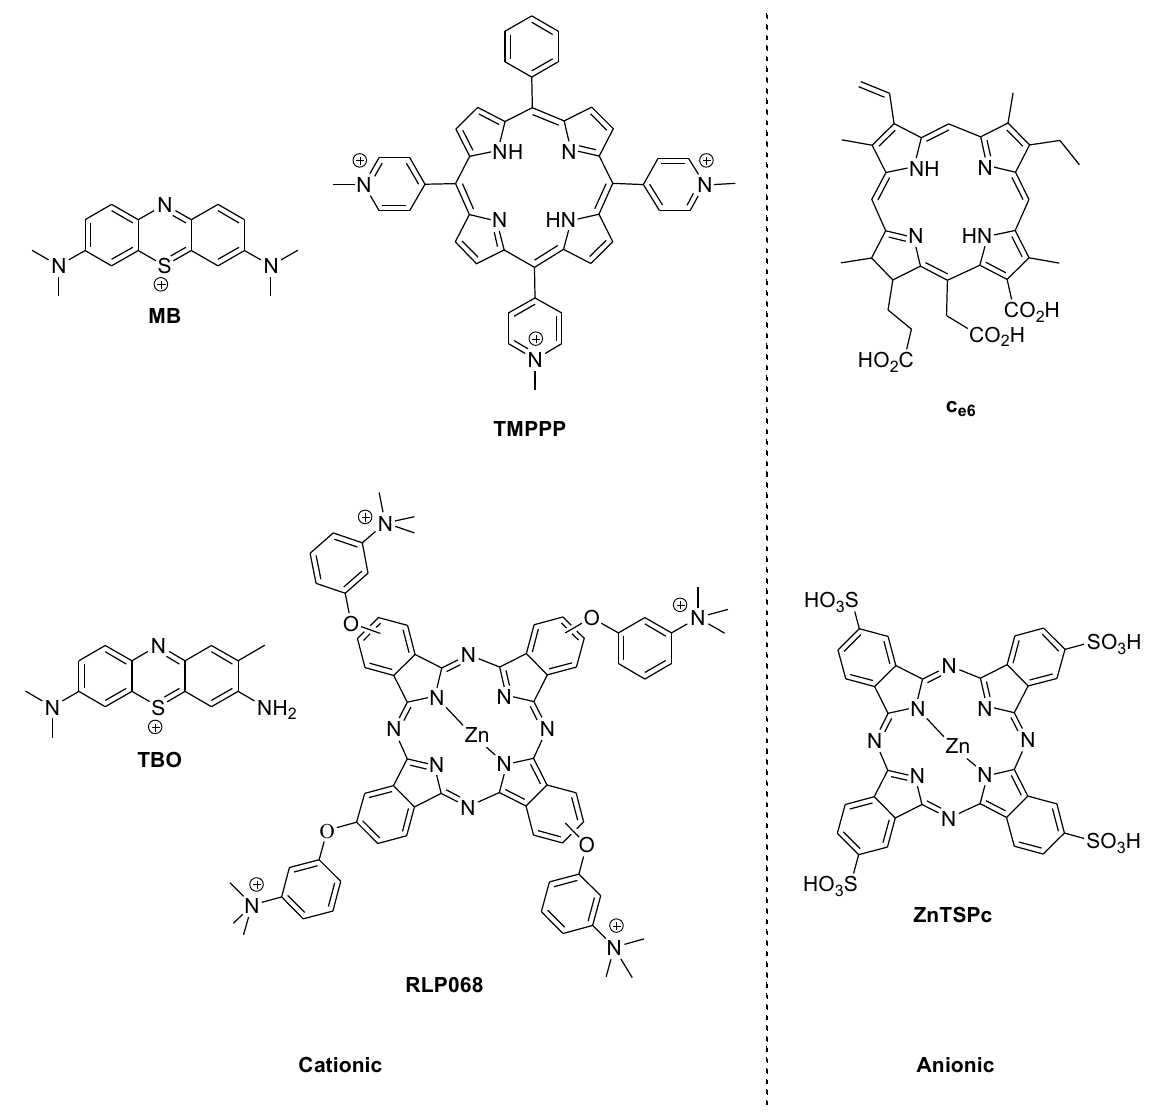
Figure 2. Photobactericides from the main classes of photosensitiser. Methylene blue (MB) and toluidine blue (TBO), phenothiazinium class; TMPPP [tri( N -methylpyrid- 4-yl)phenylporphyrin] and C , porphyrin; RLP068 and ZnTSPc, phthalocyanine. e6 Cationic examples are broad-spectrum, anionic examples are active mainly